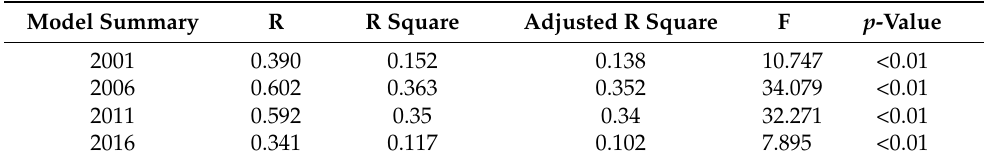
Table 5. Linear Regression Model Summary (as the p -value corresponding to the F value is less than 0.05, the regression model is statistically